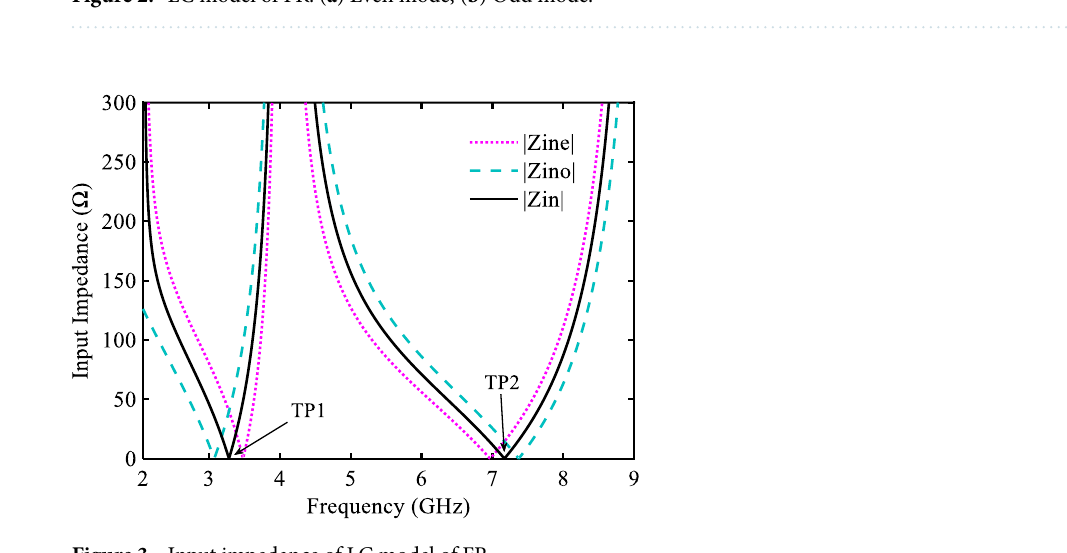
Figure 3. Input impedance of LC model of